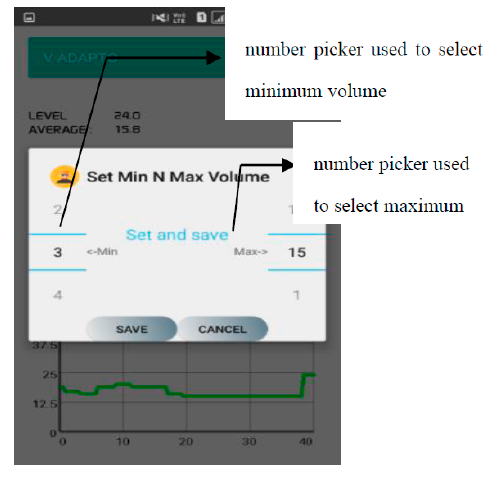
Figure 4. Minimum and maximum selector.